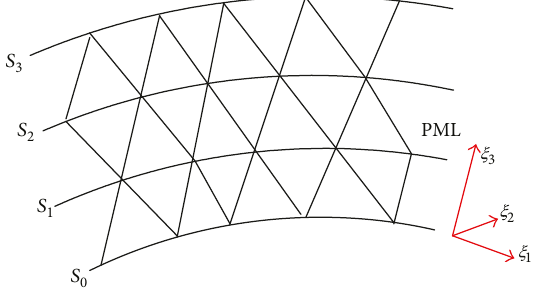
Figure 1: Discrete unit of PML in orthogonal curvilinear coordinate